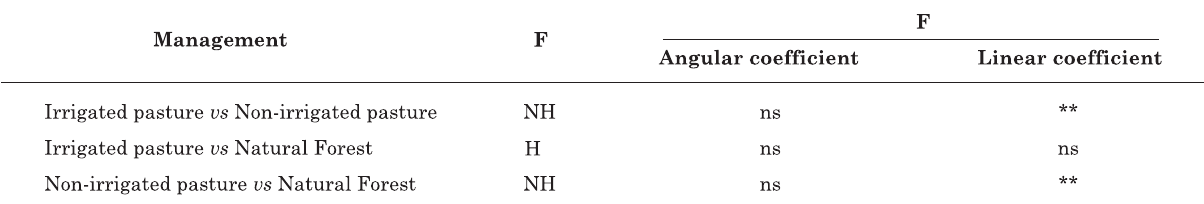
3. Significance test according to Snedecor & Cochran (1989) between the shear rupture lines of a Red-Yellow Latosol with equilibrated samples at 6